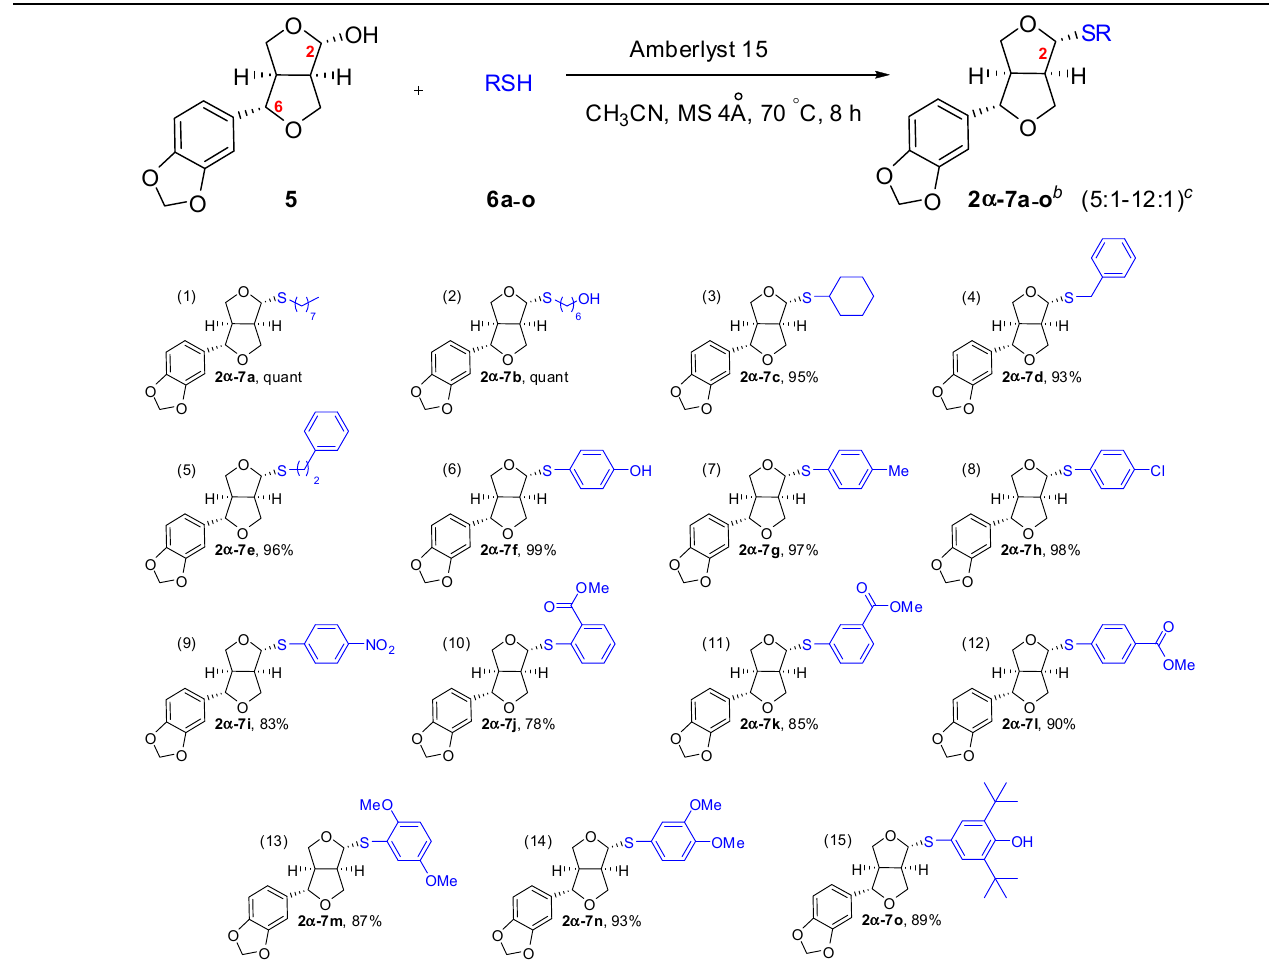
Table 1. Nucleophilic substitution of samin with thiols a .